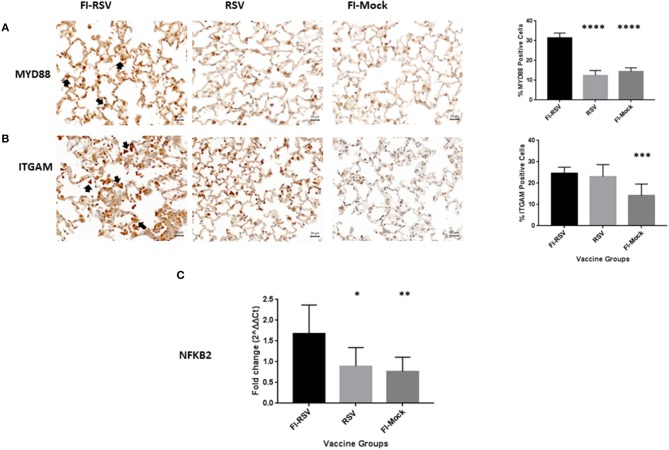
Validation of key proteins in the proteomics datasets. Immunohistochemical detection of MYD88 (A) and ITGAM (B) in lungs. For each section 15 fields of view were counted for positively stained cells in the alveoli (40× magnification). Black arrows indicate the positive staining by diaminobenzidine (DAB) substrate. The percentages of total area stained as well as the percentages of positive cells for each cytokine were calculated using one-way ANOVA, *p < 0.05, **p < 0.01, ***p < 0.001 (n = 6). Gene expression of NFKB2 (C) in the lungs was normalized to β-actin and fold change was expressed over the PBS group using the ΔΔCt method. Statistical differences in fold change were calculated using one-way ANOVA, *p < 0.05, **p < 0.01, ***p < 0.001, ****p < 0.0001 (n = 6).